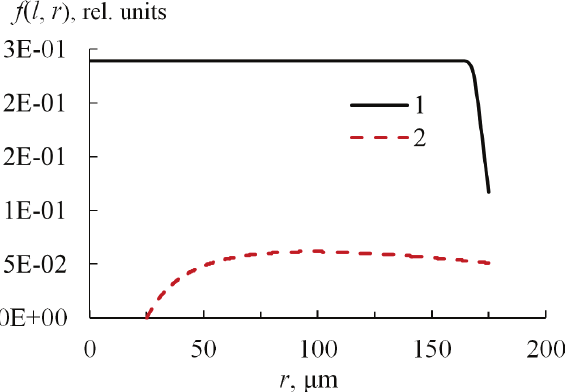
Figure 4. Spatial distribution of fission fragments within the kernel: 1 – l = 0.023; 2 – l = 1. 1 2